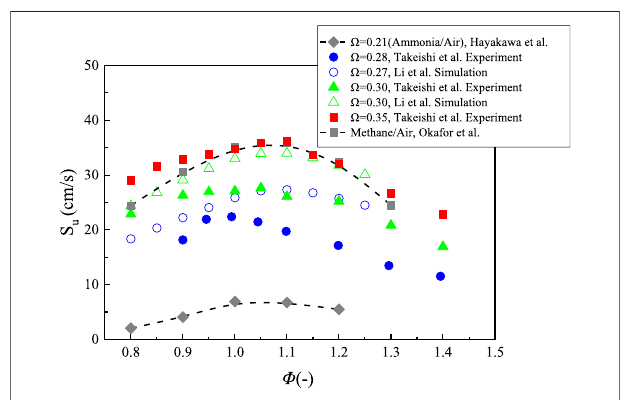
FIGURE 6 | Laminar burning velocity of NH 3 fl ame with a function of equivalence ratio at various oxygen enrichment level, replotted from (Hayakawa et al., 2015a, Takeishi et al., 2015; Li et al., 2015; Okafor et al., 2018; Kobayashi et al., 2019).